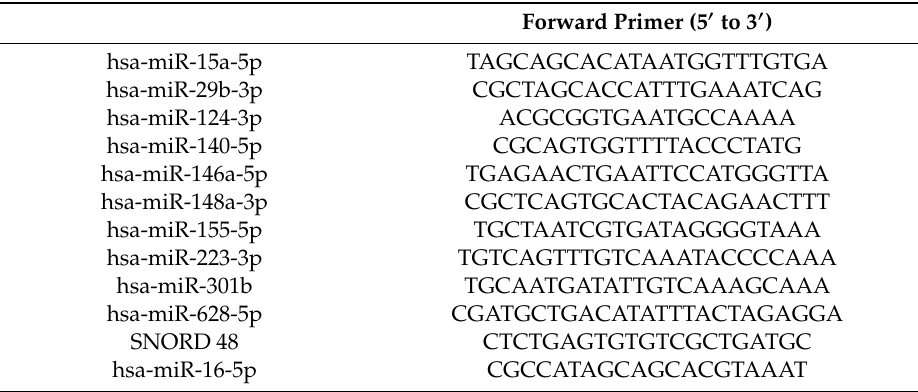
Table 2. The miRNA primers used in this